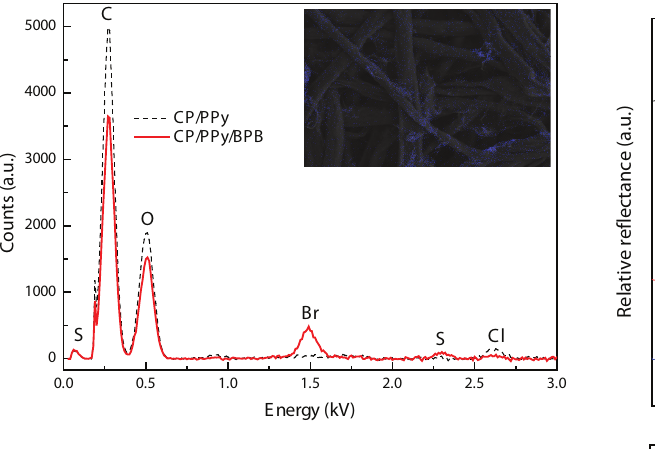
Figure 5: EDS for CP/PPy and CP/PPy/BPB.